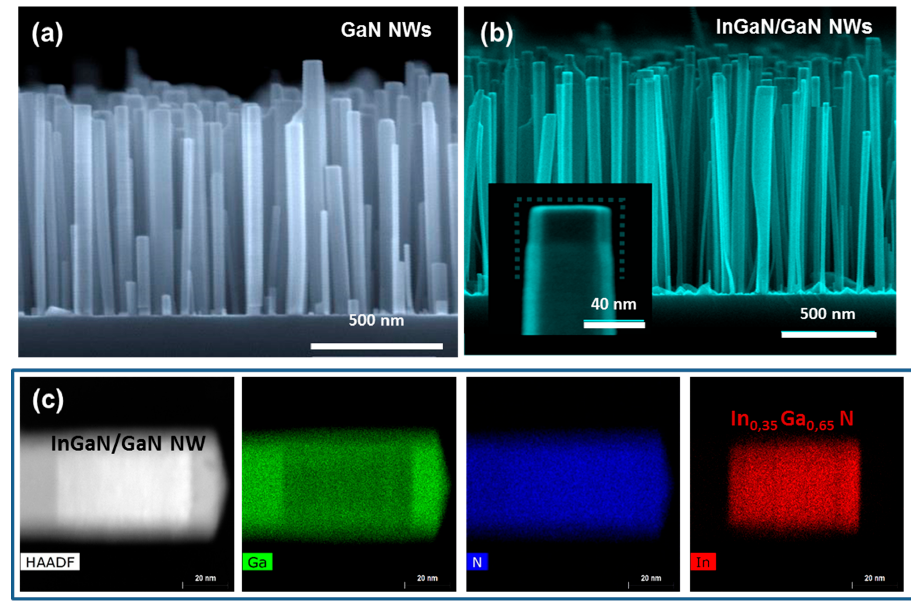
Figure 1. Scanning electron microscope images of ( a ) GaN and ( b ) InGaN/GaN nanowires (NWs) grown by plasma-assisted molecular beam epitaxy (MBE). ( c ) Transmission electron microscope image and Ga, N and In energy-dispersive X-ray spectroscopy (EDX) mappings of the top part of a capped InGaN/GaN